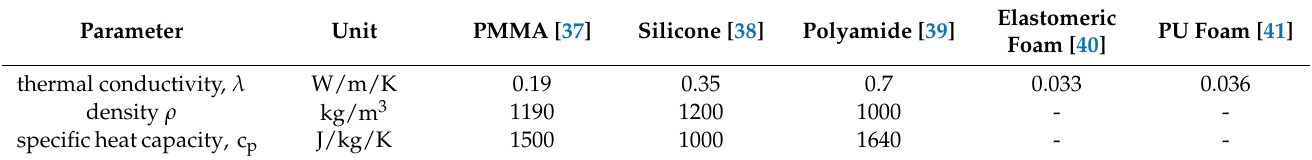
Figure 5. ( a ) Lab scale storage with four heat exchangers; (b) View on manifolds and spacers; ( c ) Positions of temperature sensors in PCM. Table 3. Material properties of storage systems.